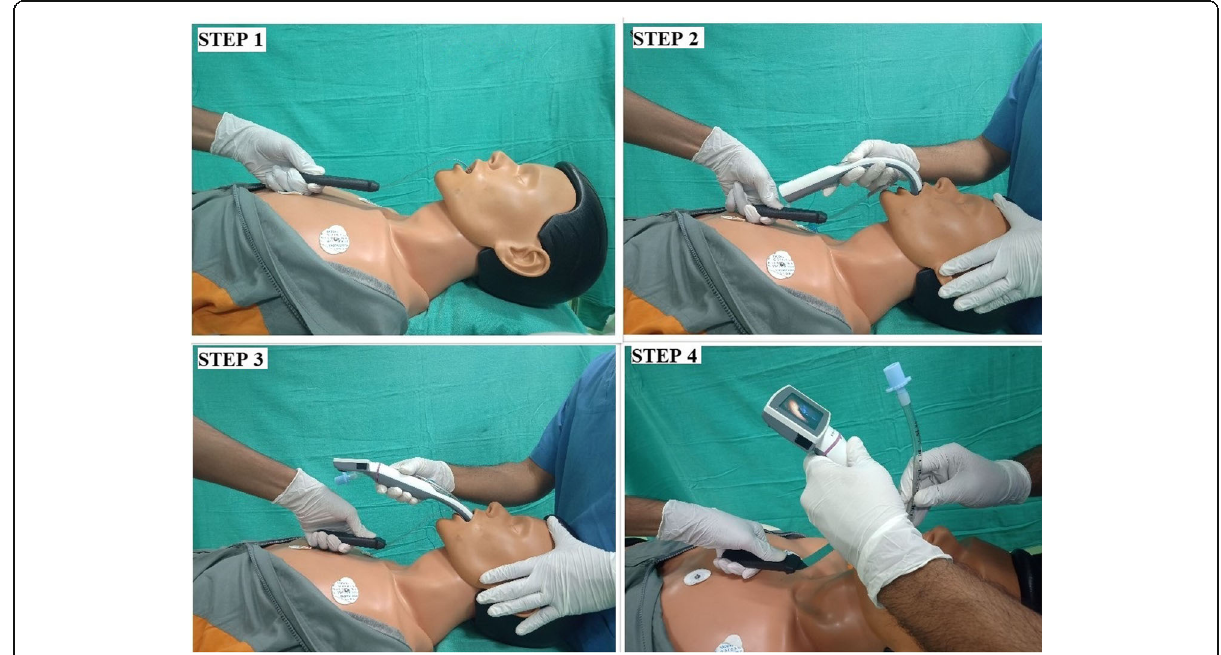
Fig. 2 Steps to use the Ari ’ s airway spatula as an introducer for King Vision